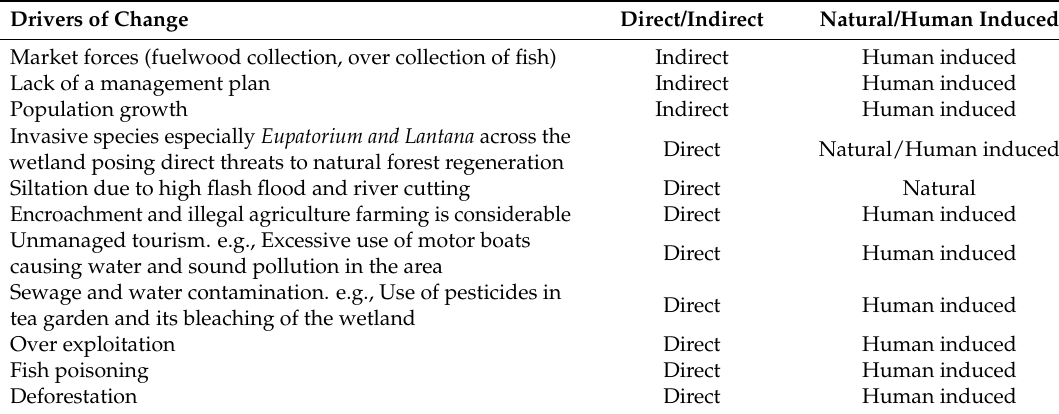
Table 4. Drivers of change in Maguri-Motapung Beel Wetland of Assam.